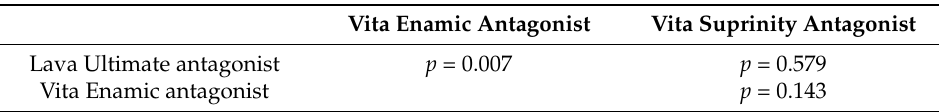
Table 6. Results of the Mann-Whitney U test comparing of the median value of the total occlusal abrasive wear (volume loss) of the natural antagonists between the tested material groups. Results of the comparison of the total abrasive wear between all of the materials. Vita Enamic Antagonist Vita Suprinity Antagonist Lava Ultimate antagonist p = 0.007 p = 0.579 Vita Enamic antagonist p =